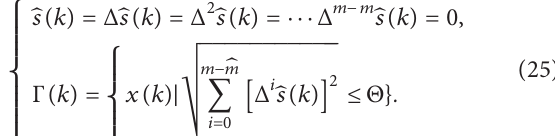
Figure 4: The implementation of noncooperative game scheduling for